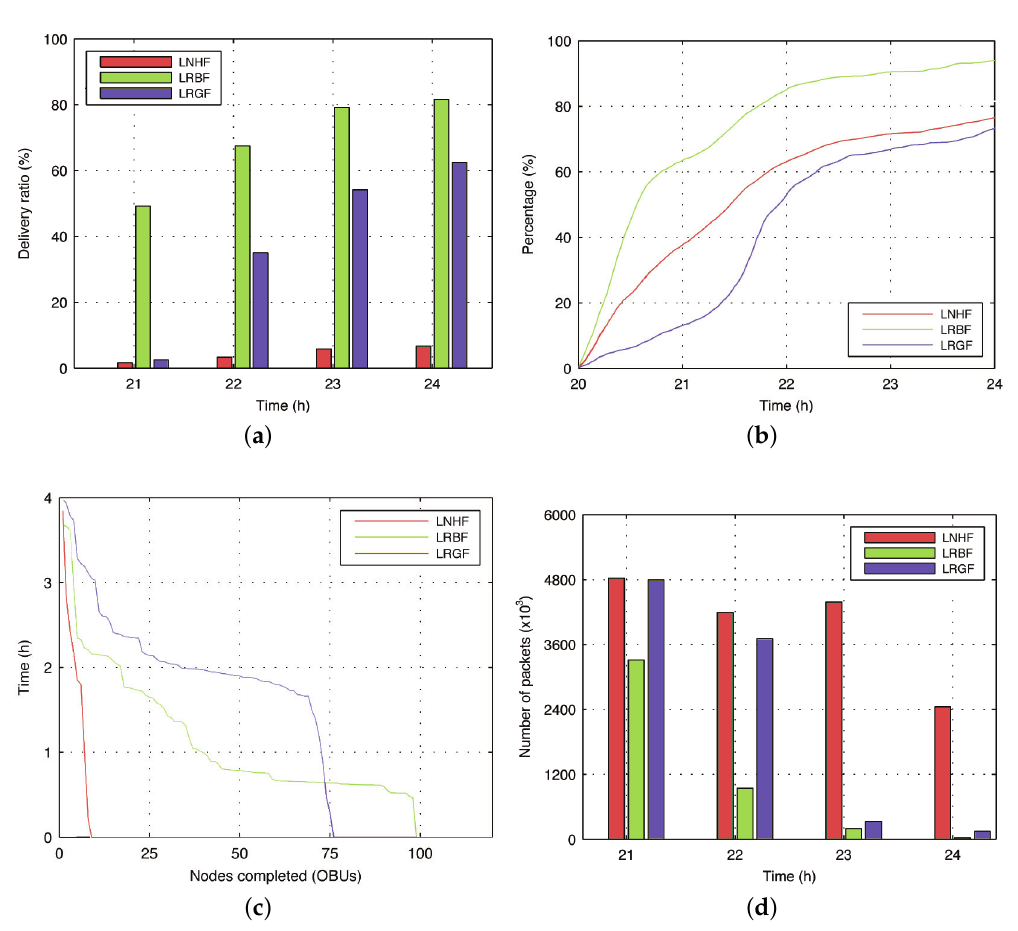
Figure 13. Performance of LNHF, LRBF and LRGF strategies for the Parking period. ( a ) Delivery rate; ( b ) Percentage of file distribution; ( c ) E2E delay; ( d ) Number of listened